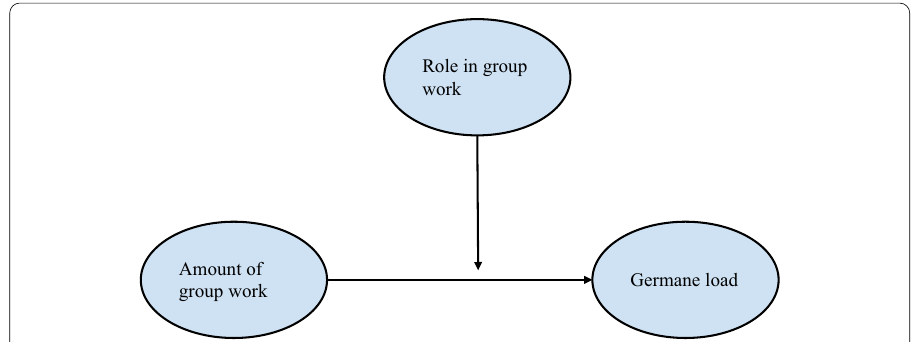
Fig. 1 The moderating effect of group contribution on the relationship between amount of group work and germane load